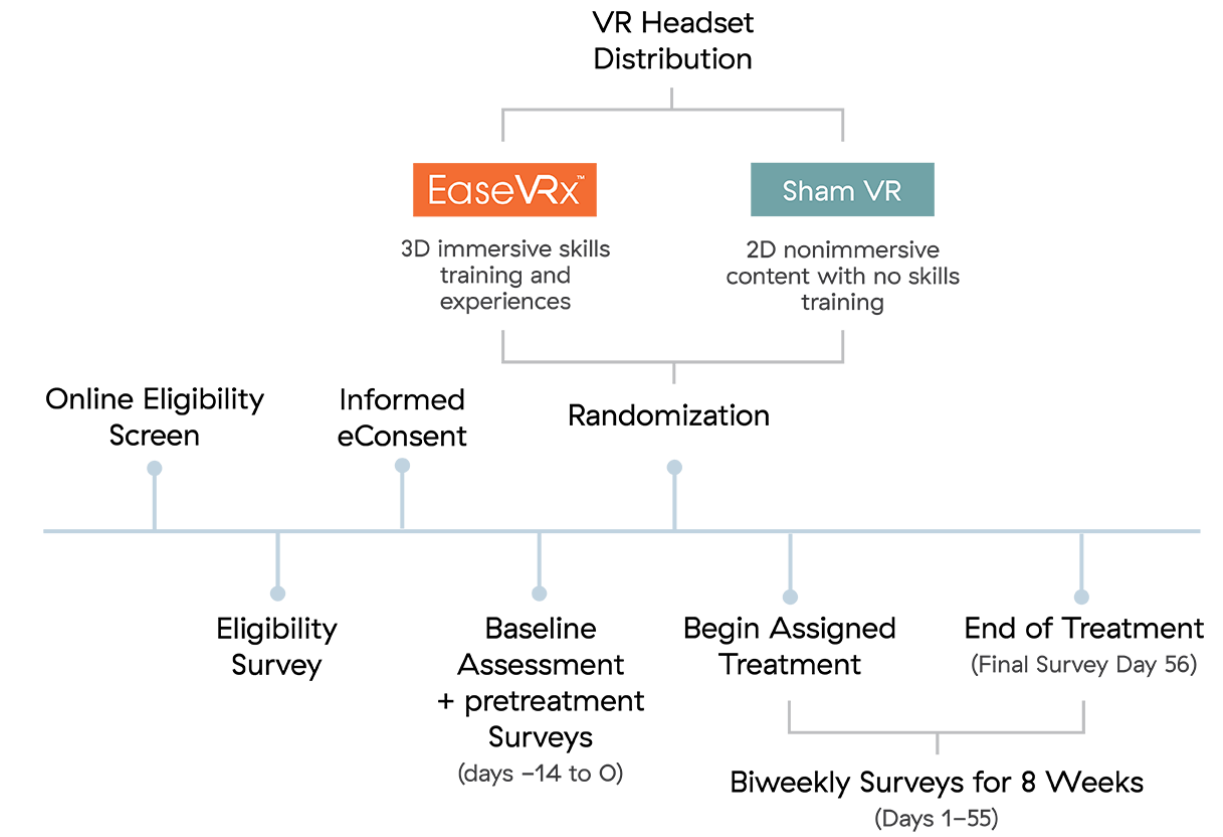
Figure 1. Participant